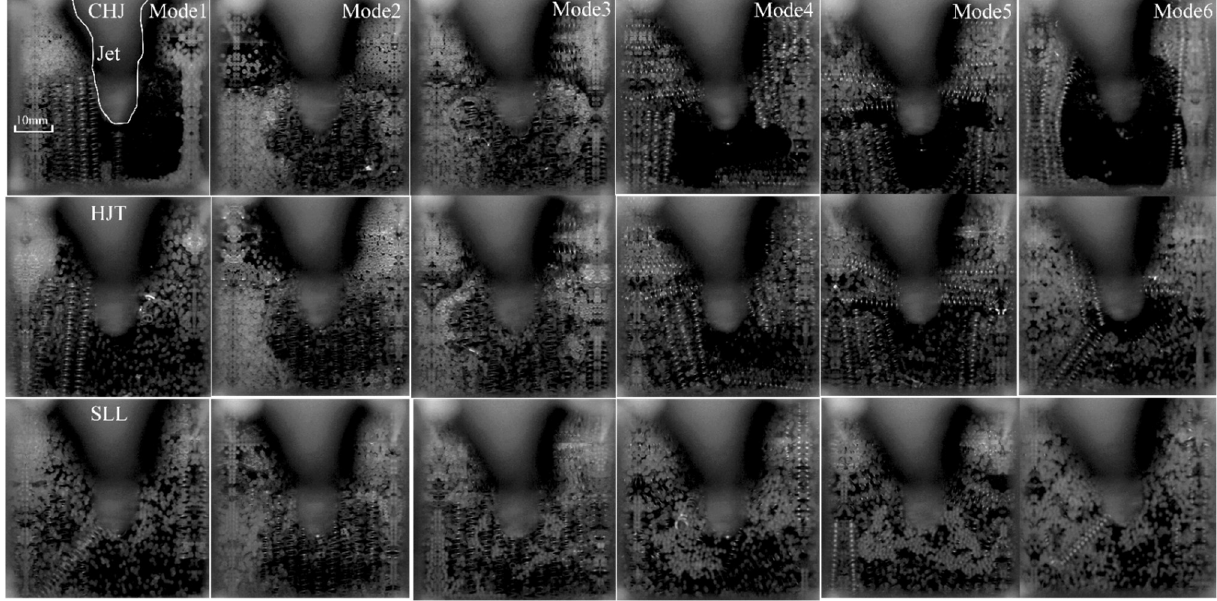
Figure 6. The hydraulic jump form and spring and particles arrangement in three physical forms of the hydraulic jump of the top view (casting speed of 0.8 m/min, modes 1–6). the hydraulic jump of the top view (casting speed of 0.8 m/min, modes Modes 1 and 6: The surface flow is affected by the initial arrangement and the wall spring arrangement for the hydraulic jump is the smallest.